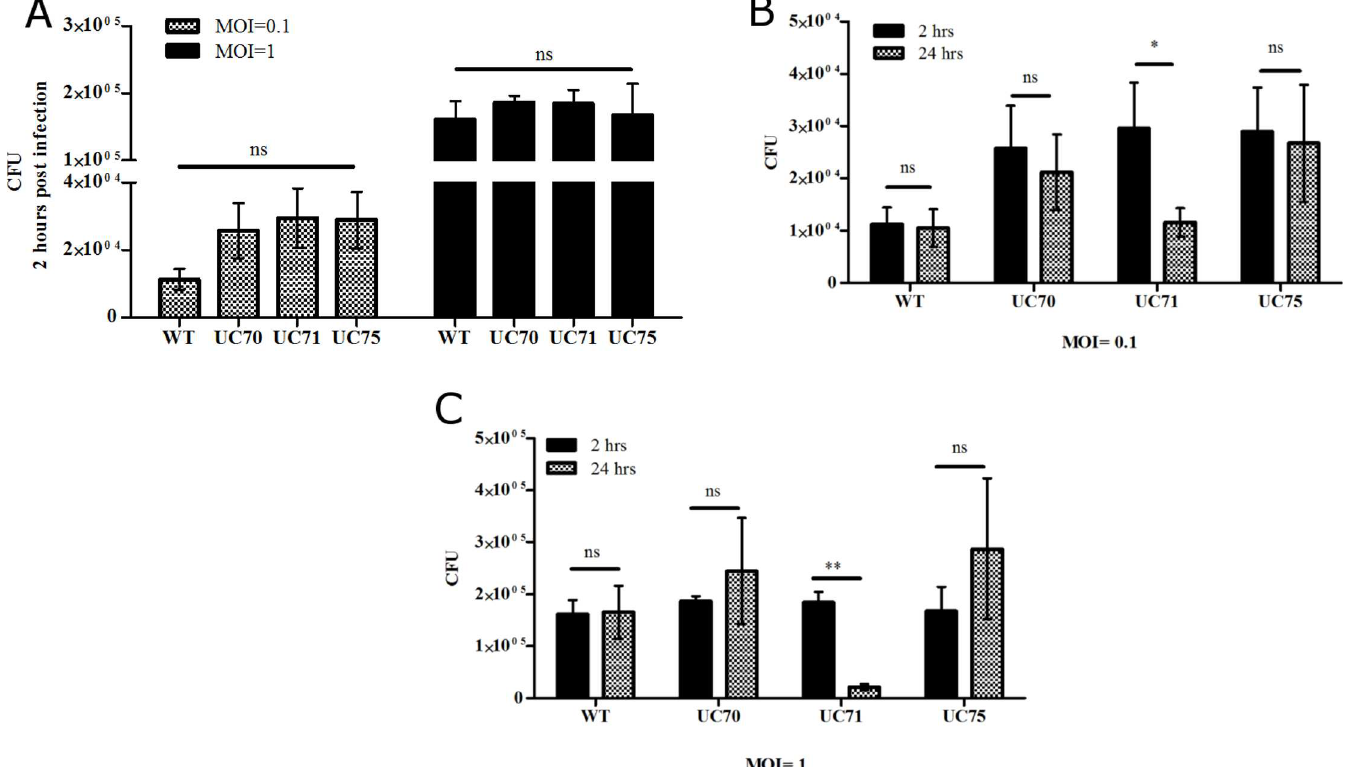
Fig 4. Loss of Srb1 reduces H . capsulatum survival within murine macrophages. (A) An equal number of colony-forming units (CFU) recovered from bone marrow derived macrophages (BMDM) after 2 hours of infection with WT, UC70 or UC72. Chart depicts CFU after 24 hours post infection at a multiplicity of infection (MOI) of (B) 0.1 and (C) 1. Results represent the mean ± SEM of 4 independent experiments.